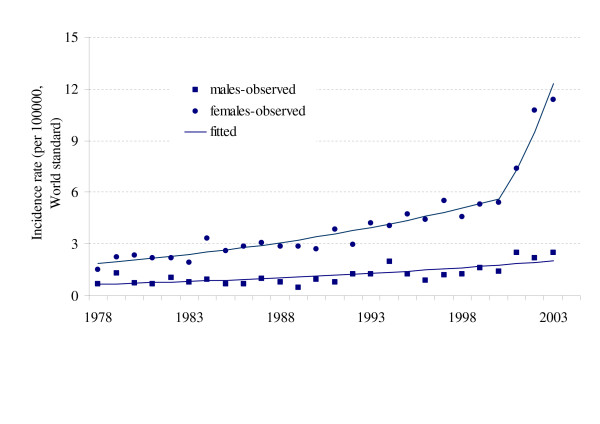
Age-standardised (per 100 000 world standard) thyroid cancer incidence rates in Lithuania, 1998–2003.